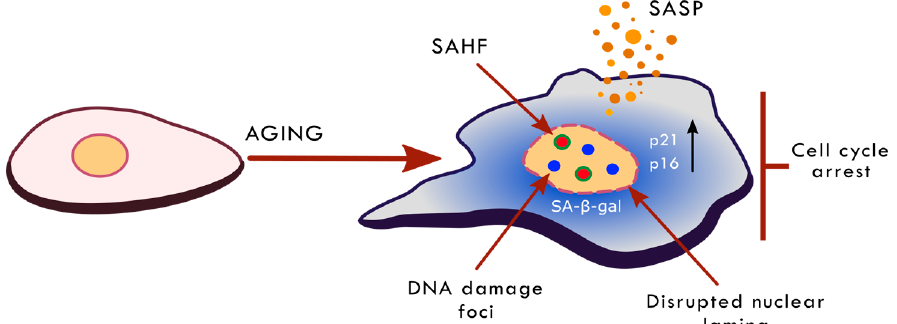
Figure 1. Global changes and markers of senescent cells. During ageing, the accumulation of senescent cells is often observed. Senescent cells are characterized by permanent cell cycle arrest, increased size, elevated activity of senescence associated β galactosidase (SA- β -gal) and higher levels of cell cycle inhibitors, p16 and / or p21. Moreover, senescent cells secrete various proteins such as cytokines, growth factors and proteases. This phenomenon is generally referred as senescence associated secretory phenotype (SASP). Nuclear changes are manifested by disrupted structure of nuclear lamina (for instance, due to downregulation of Lamin B1), local condensation of chromatin in the form of senescent associated heterochromatin foci (SAHF) and by DNA-SCARS (DNA segments with chromatin alterations reinforcing senescence), which form in response to DNA damage.